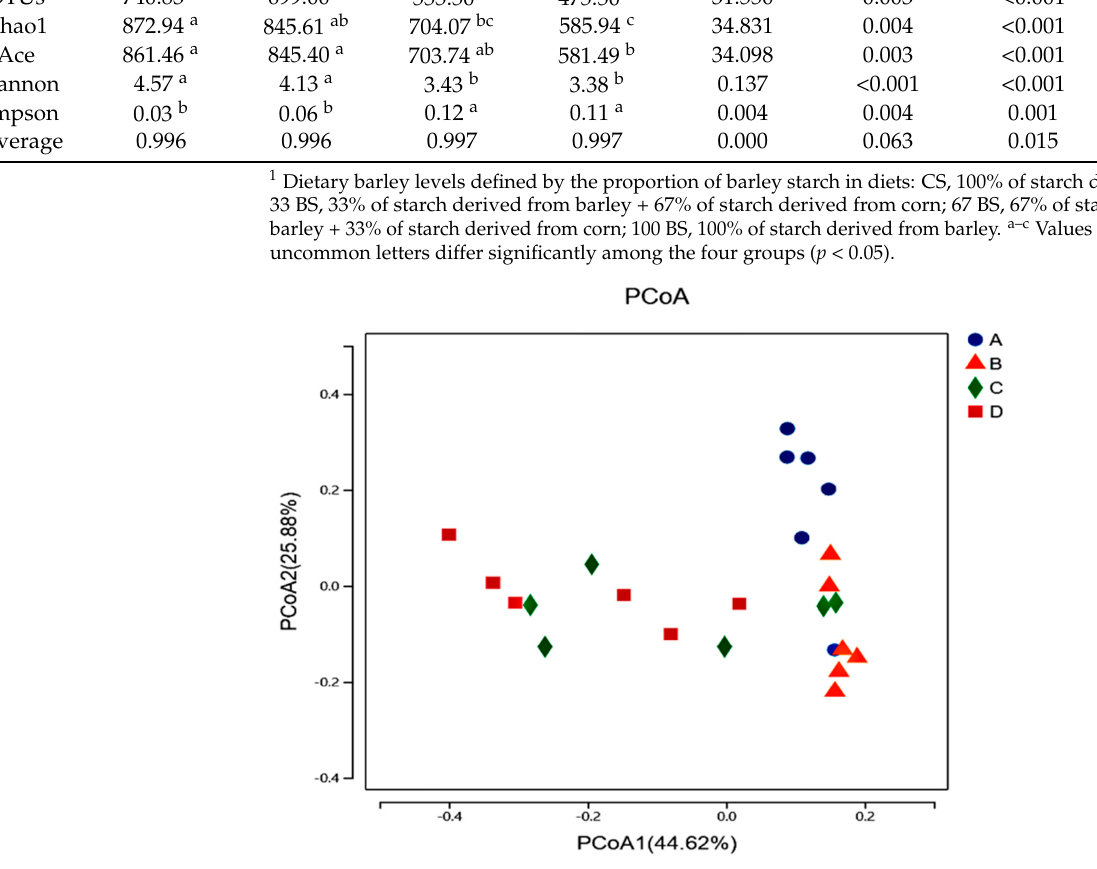
Figure 1. Analysis of β − diversity at 2 h after morning feeding among different treatment groups. “A” represents the CS group, with 100% of starch derived from corn; “B” represents the 33 BS group, with 33% of starch derived from barley + 67% of starch derived from corn; “C” represents the 67 BS group, with 67% of starch derived from barley + 33% of starch derived from corn; “D” represents the 100 BS group, with 100% of starch derived from